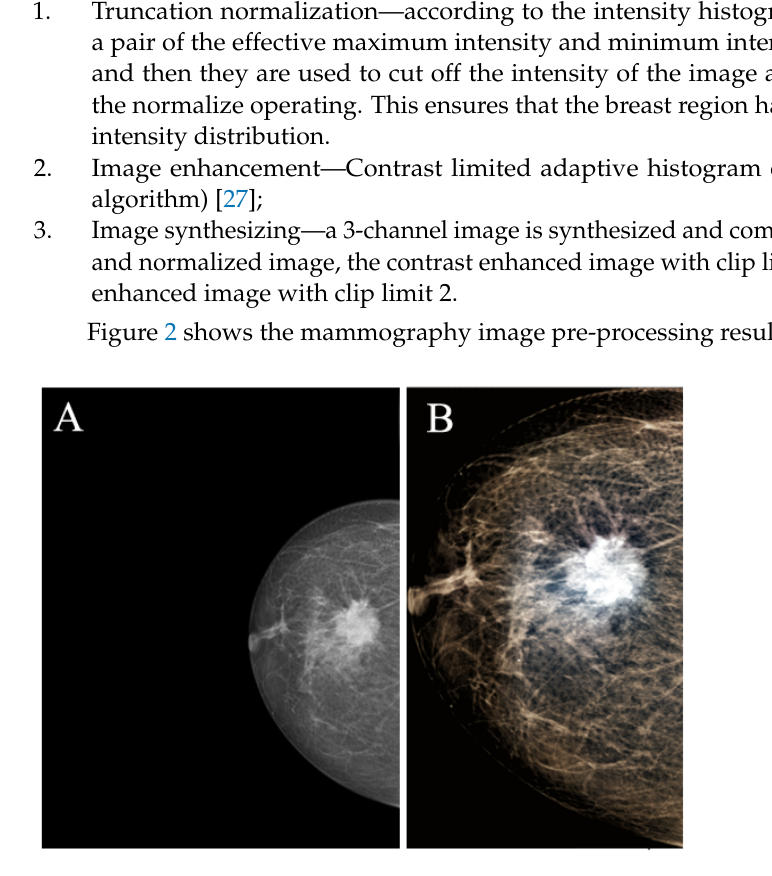
Figure 2. The result of the source image pre ‐ processing. ( A ): source image; ( B ): after pre ‐ processing. The dataset was split into two subsets to train YOLOv4: the training subset included 90% of the images and the validation subset included 10% of the images. We used the graphic processor NVIDIA Tesla K80 (16 Gb memory) to train the YOLOv4. The size of the input image was 608×608.